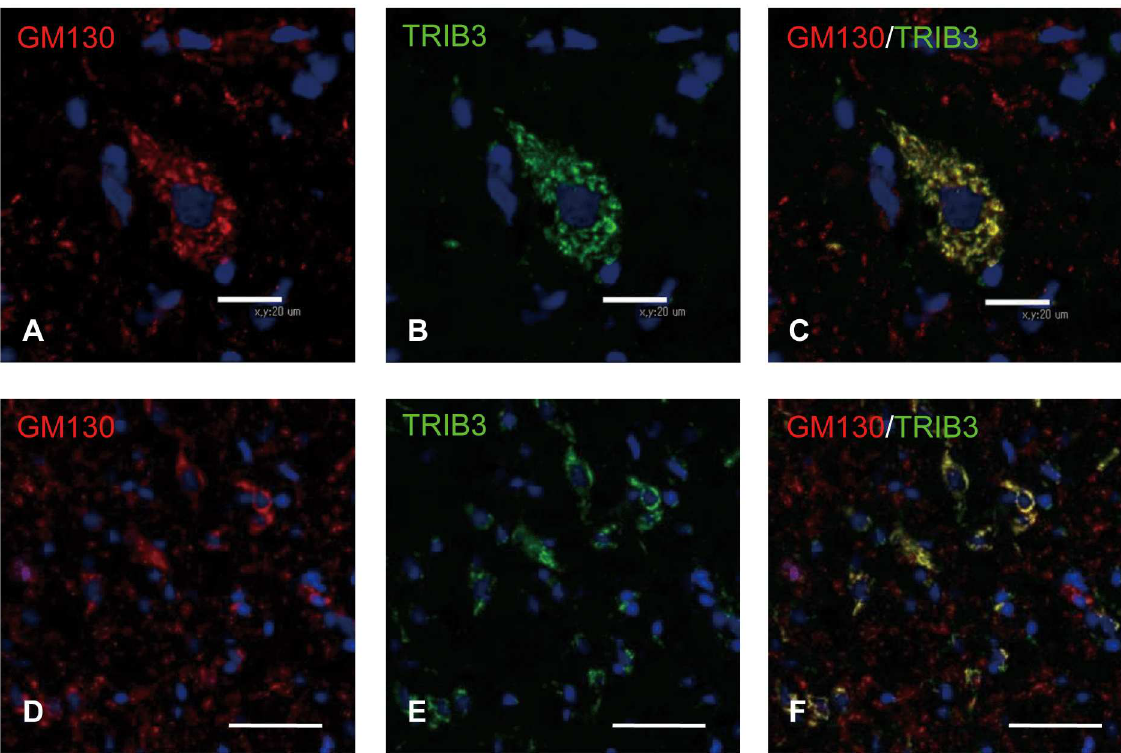
Fig 5. Double immunofluorescencefor GM130 and TRIB3. The doubleimmunohistochemistry for GM130 and TRIB3 in the gray matter (A-C) and white matter (D-F) of the lumbar spinal cords from the dmy rats at 7-week-old. There are many GM130/TRIB3 doublepositive cells in the gray matter (A-C) and white matter (D-F) of the dmy rats. Bars: 20 μ m (A-C), 50 μ m